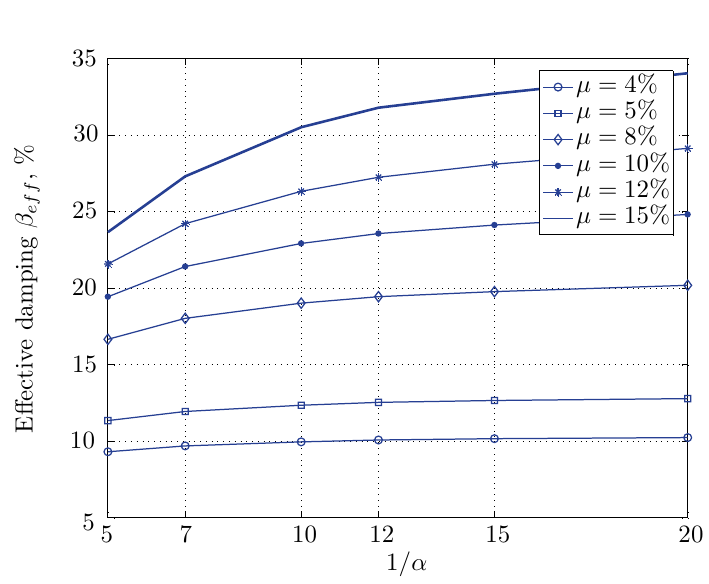
Figure 32. Effective damping for various isolation system parameters